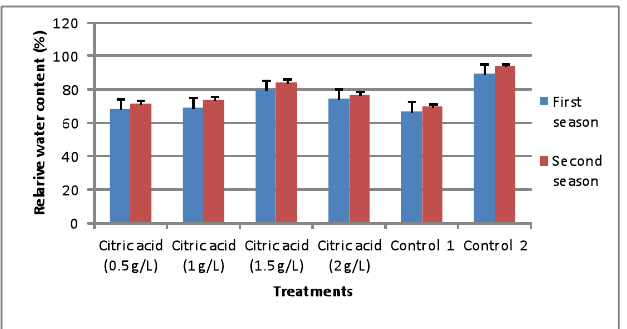
Fig. 3: Effect of different levels of citric acid on relative water content of leaves of bean plants subjected to drought stress conditions. Control 1: plants not treated by citric acid, but stressed. Control 2: plants not treated by citric acid and kept at field capacity during the entire experiments. Vertical bars present LSD value at 5%.